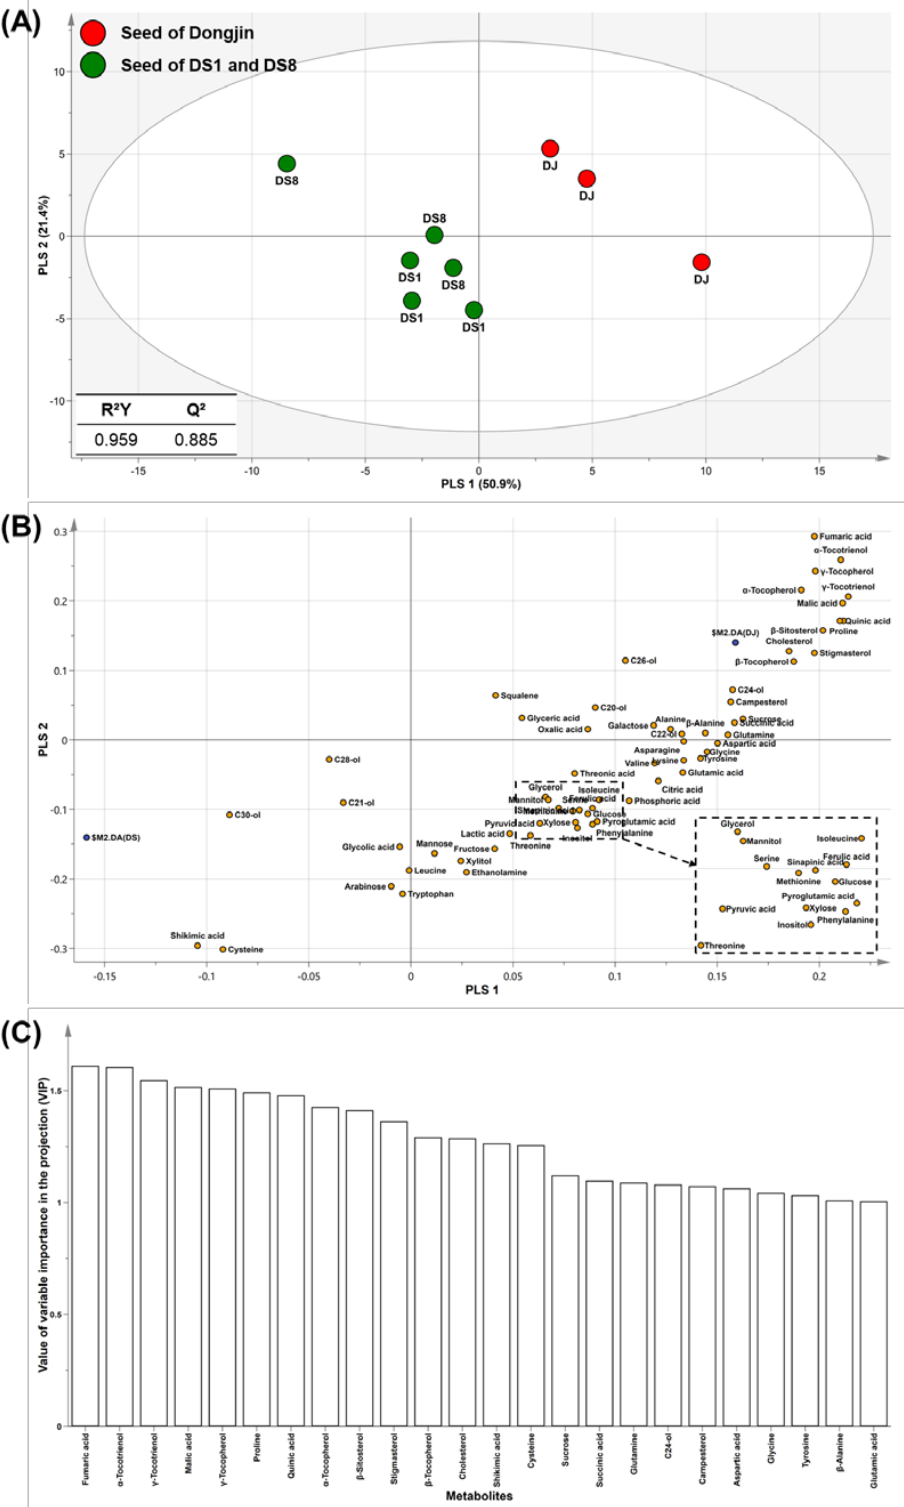
Figure 2. Score ( A ), loading ( B ) plots and variable importance in the projection (VIP) ( C ) of the PLS- DA models on rice seed. Abbreviations: DJ, Oryza sativa L. cv. Dongjin; DS1, line 1 of transformed rice from DJ with PgDDS and CYP716A47 genes; DS8, line 8 of transformed rice from DJ with PgDDS and CYP716A47 genes; C20-ol, eicosanol; C21-ol, heneicosanol; C22-ol, docosanol; C24-ol, tetracosanol; C26-ol, hexacosanol; C28-ol, octacosanol; C30-ol,